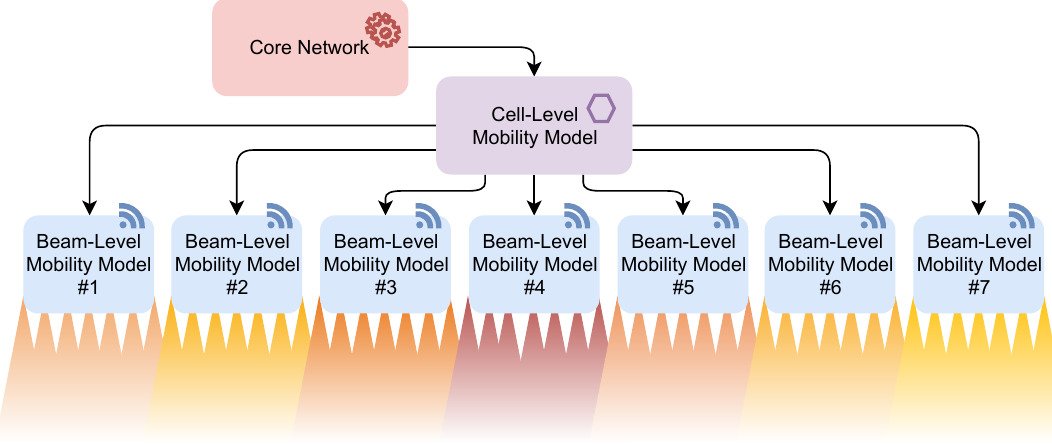
Figure 2. Proposed hierarchical system model.